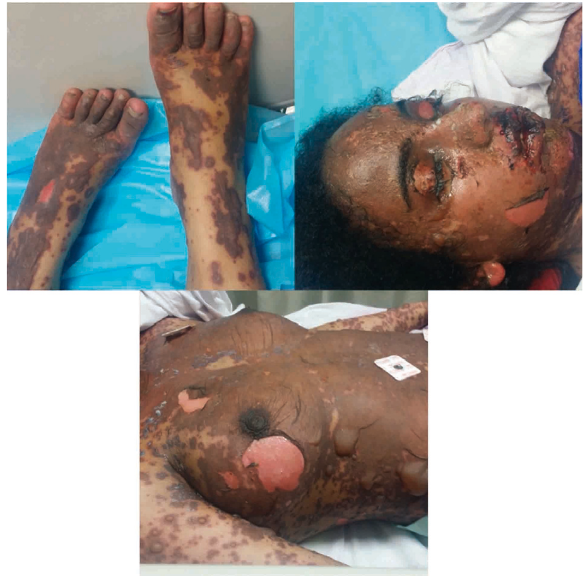
Figure 1: Diffuse skin desquamation resembling burns covering almost 90% of the patient’s